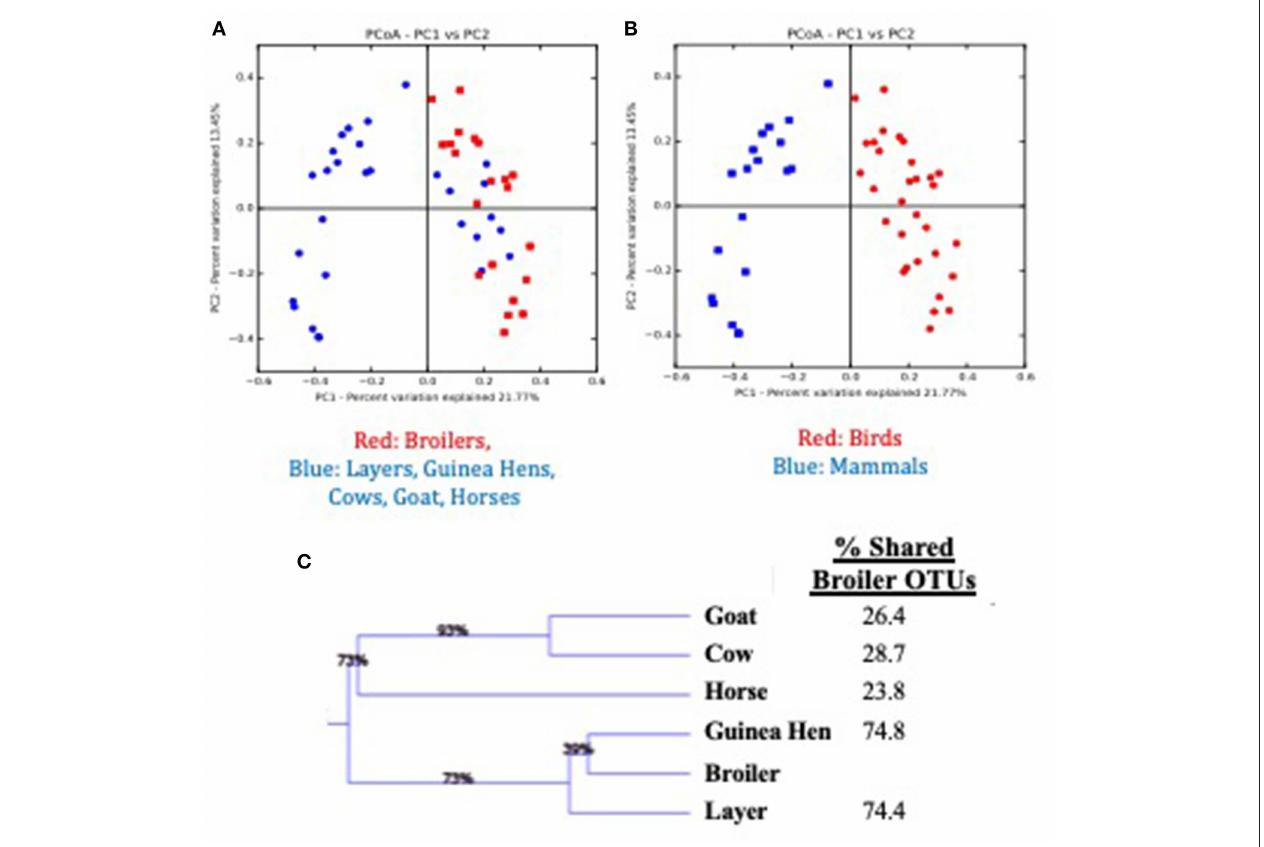
FIGURE 4 | Comparison of feces from multiple animal species present during the pre-harvest (live production) period for a pasture-raised broiler flock. (A) Principle Coordinate Analysis (PCoA) plot based on Bray Curtis dissimilarities comparing broiler feces (red) to all other feces (blue) recovered on pasture during live production. (B) Principle Coordinate Analysis (PCoA) plot based on Bray Curtis dissimilarities comparing bird feces (Broilers, Layers, Guinea Hens; red symbols) to mammal feces (Cow, Goat, Horse; blue symbols) recovered on pasture during live production. (C) WPGMA comparison of fecal microbiomes from different animals, with the final column describing the percent of OTUs shared with the broiler microbiome.